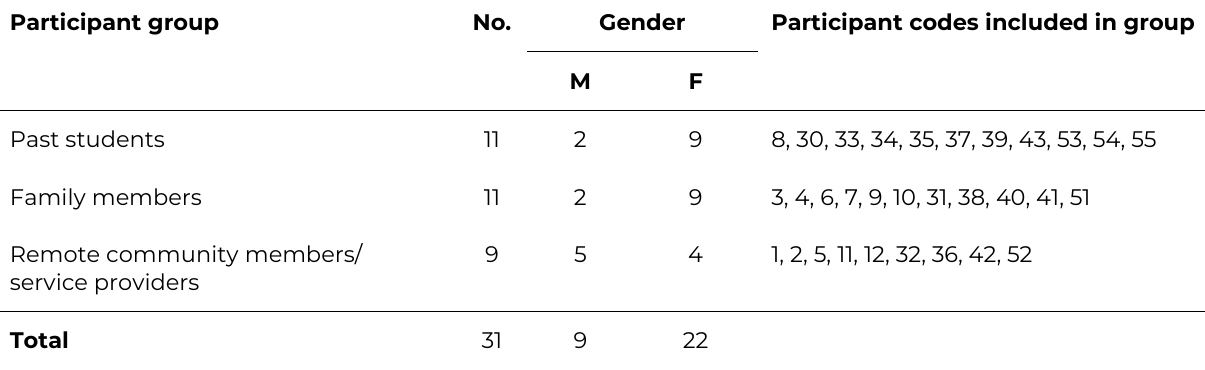
Table 1: Breakdown of participants by type, gender and code Participant